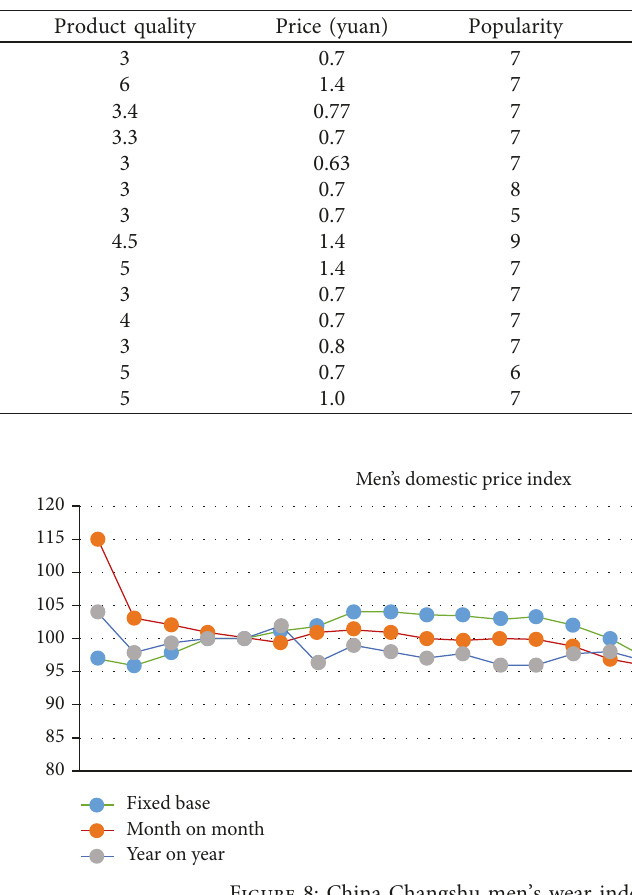
Table 6: Marketing combination strategy and market share simulation value.